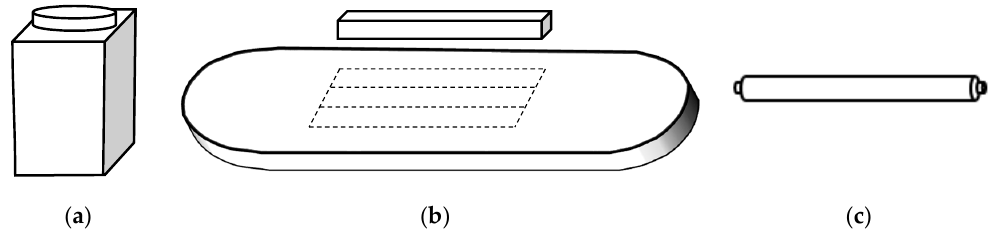
Figure 6. Sequence of fabrication of test specimen: ( a ) ingot; ( b ) plate rolled; ( c ) cylindrical specimen.